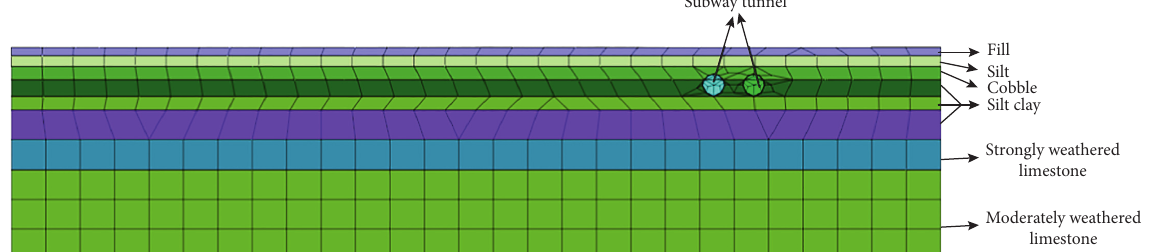
Figure 14: Soil layer